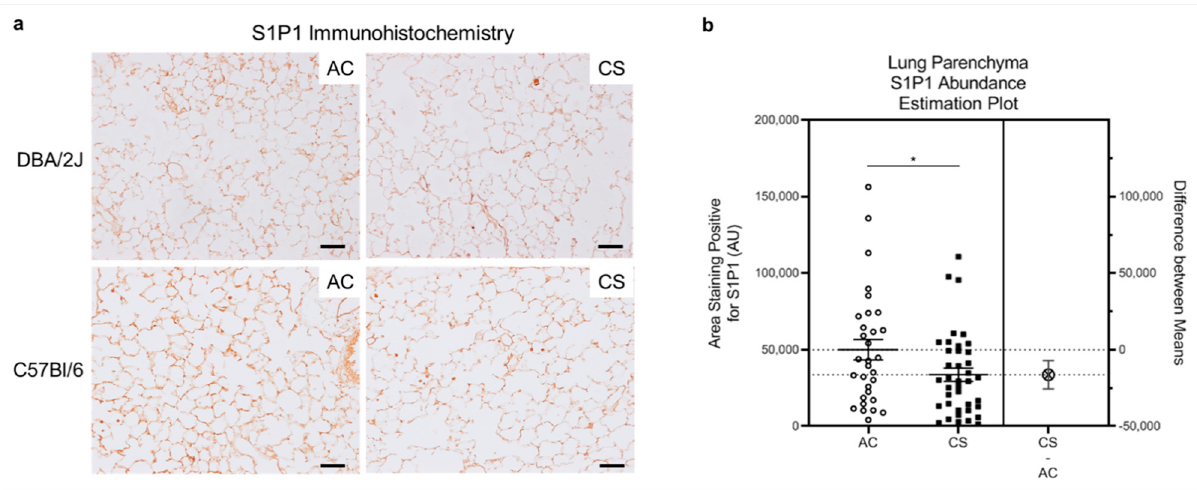
Figure 3. S1P1 in Lung Parenchyma of Mice Chronically Exposed to Cigarette Smoke (CS). ( a ) Representative images of S1P1 abundance (brown) in the alveolar regions of mouse lungs determined by immunohistochemistry (IHC) in DBA/2J mice (n = 4) or C57Bl/6 mice (n = 3) exposed to ambient air control (AC) or CS for 6 months. Note the overall decreased S1P1 staining in CS mice. IHC was performed on paraffin-embedded lung tissue sections with anti-S1P1 antibody (1:50). Scale bar is 50 µm. ( b ) Quantitative assessment of the alveolar area staining positive for S1P1 by IHC in DBA/2J mice (n = 4) exposed to AC or CS for 6 months, obtained by automated analyses of images captured by an operator blinded to the identity of the slides. Each data point represents average from a lung parenchyma image; horizontal lines are mean ± SEM. * p = 0.04; 2-tailed unpaired Student’s t -test with Welch correction.